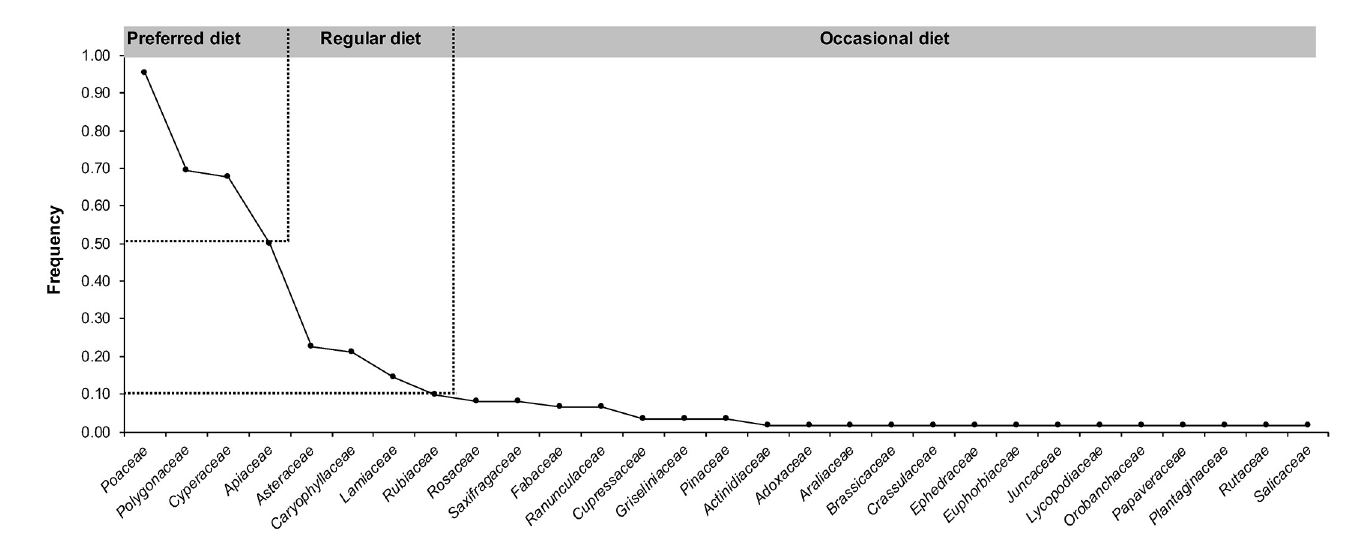
Fig 1. A frequency plot of plant families in the diet of brown bears in Deosai National Park, Pakistan, identified by the trn L approach.